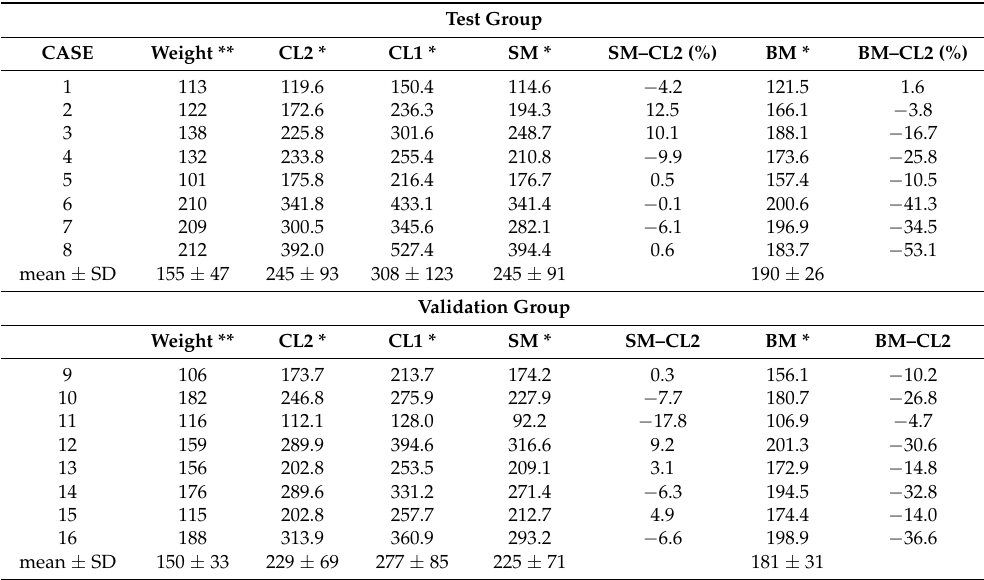
Table 1. Iohexol plasma clearance in the one- (CL1) and two-compartment (CL2) models in the test